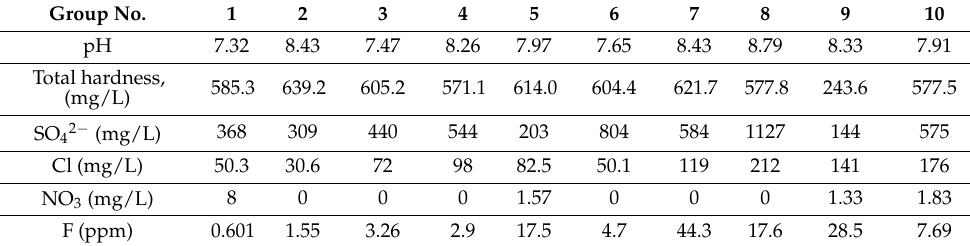
Table 2. Coal mine water quality analysis. Group